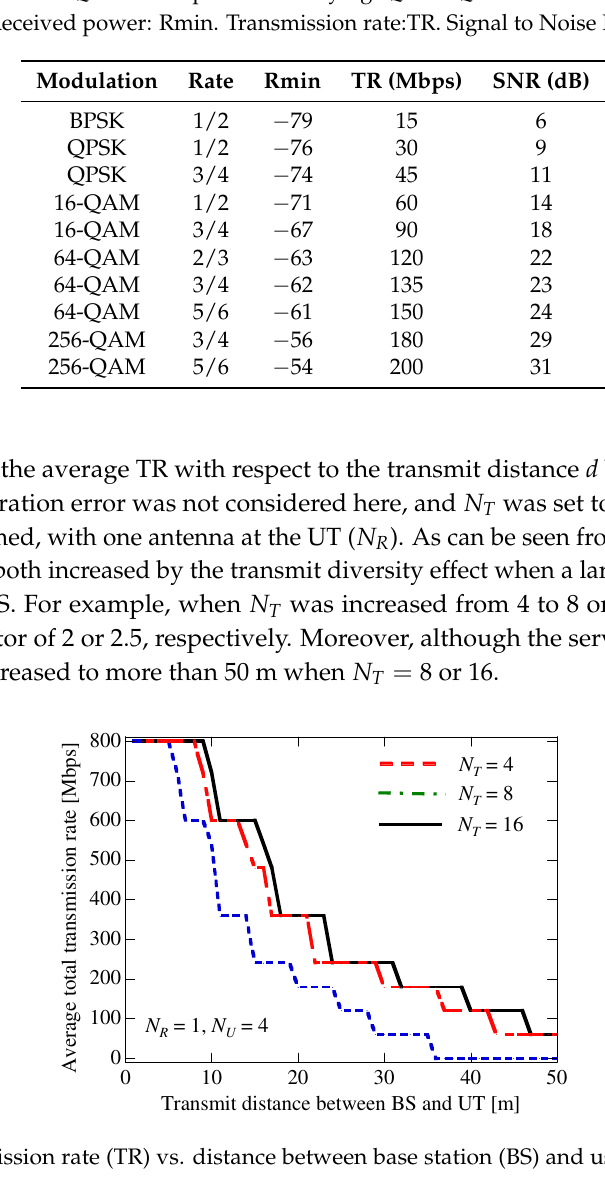
Table 3. Relationship between modulation scheme and transmission rate (TR; 40 MHz mode). (Binary